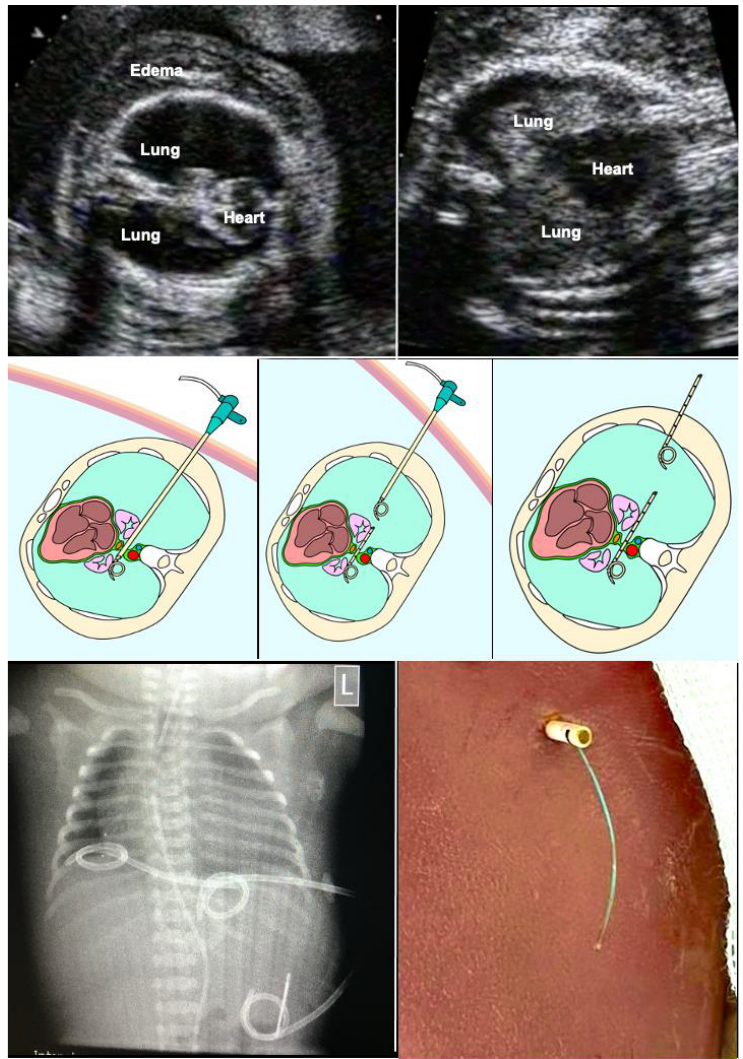
Figure 10. Bilateral thoraco-amniotic drainage from a single insertion site. Top left — before the intervention, bilateral hydrothorax with severe pulmonary and cardiac compression as well as marked skin edema are observed at 26 weeks of gestation. Top right — after the intervention, the lungs are distended again and cardiac filling has improved. Technique: middle left — without manipulation of fetal position or amniotic fluid augmentation, a catheter sheath is placed closely above the diaphragm from the proximal into the distal thoracic cavity. Via the sheath, an adequately trimmed single pigtail catheter (about 5 cm) is placed across the midline such that it connects both chest cavities. Middle center — then, the sheath is pulled back into the proximal chest cavity. Middle right — here a second catheter is placed, extending from the proximal chest cavity for about 6 cm into the surrounding amniotic cavity and uterine wall. Following passive drainage of the bilateral effusions via the catheter sheaths and catheters, the catheter sheath is removed without further manipulation and the maternal abdominal skin incision is closed with a single stitch. As soon as the fetus awakens from anesthesia and begins to move again, it pulls the distal end of the catheter into the amniotic cavity, thus completing the